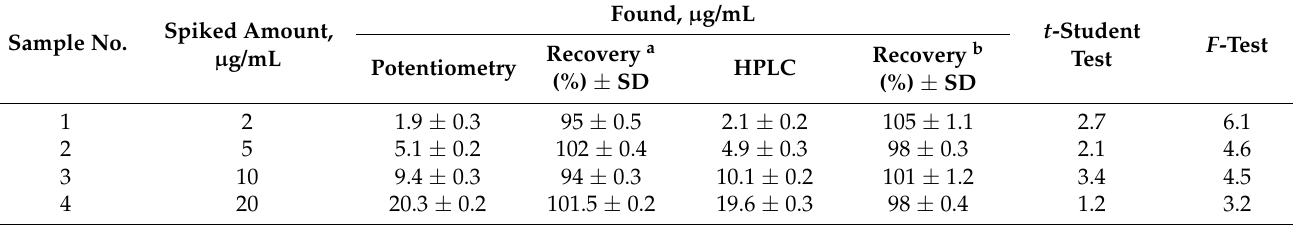
Table 4. Harmine assessment in spiked urine specimens using C/PEDOT:PSS/harmine-ISE. Sample No.